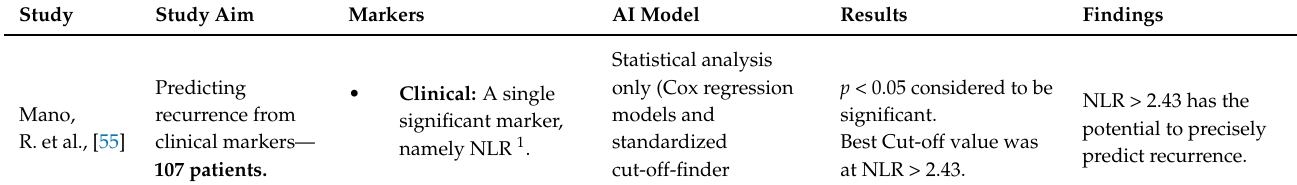
Table 3. Literature review on the use of clinical markers to predict recurrence in